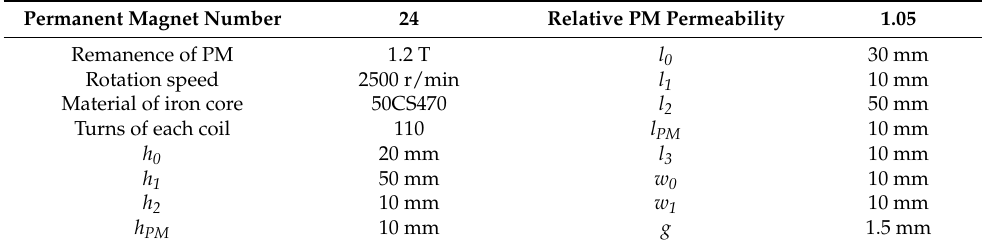
Figure 8. Initial TFPMDG: ( a ) The basic structural unit; ( b ) The dimension parameters. Table 1. Parameters of the